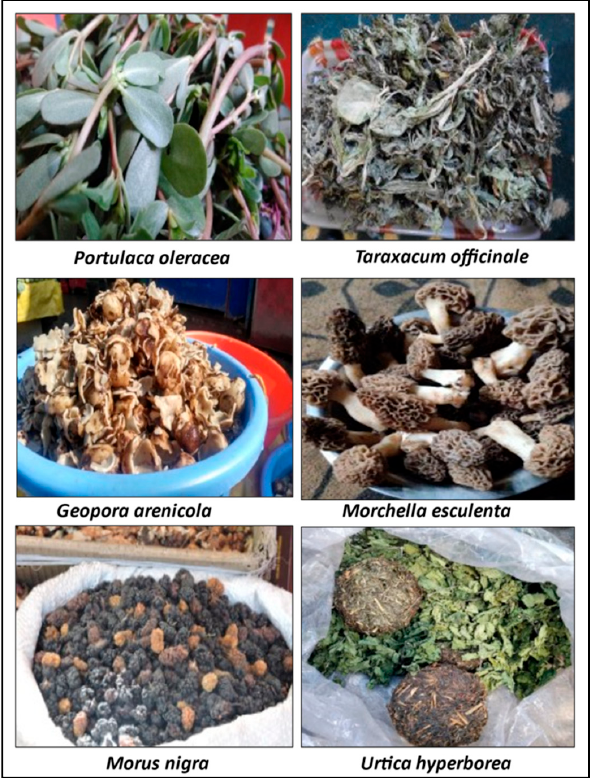
Figure 3. Representative species used as wild food (plants). The photographs were taken by Shiekh Marifatul Haq and Musheer ul Hassan.